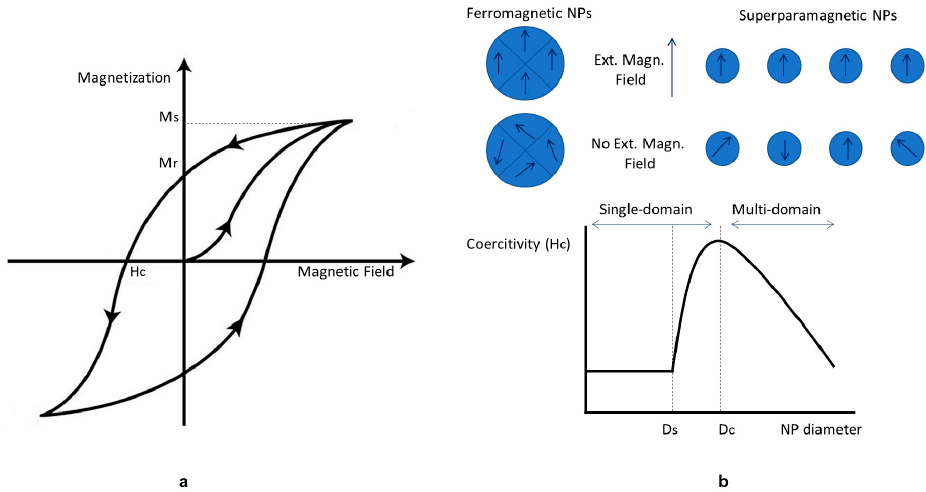
Figure 6. Principal features of magnetic material: ( a ) Hysteresis loop of ferromagnetic and ferrimagnetic materials. Critical magnetic parameters: Saturation magnetization ( M s ), Coercive field ( H c ), and Remnant Magnetization ( M r ) are shown. ( b ) Magnetization behavior of ferromagnetic